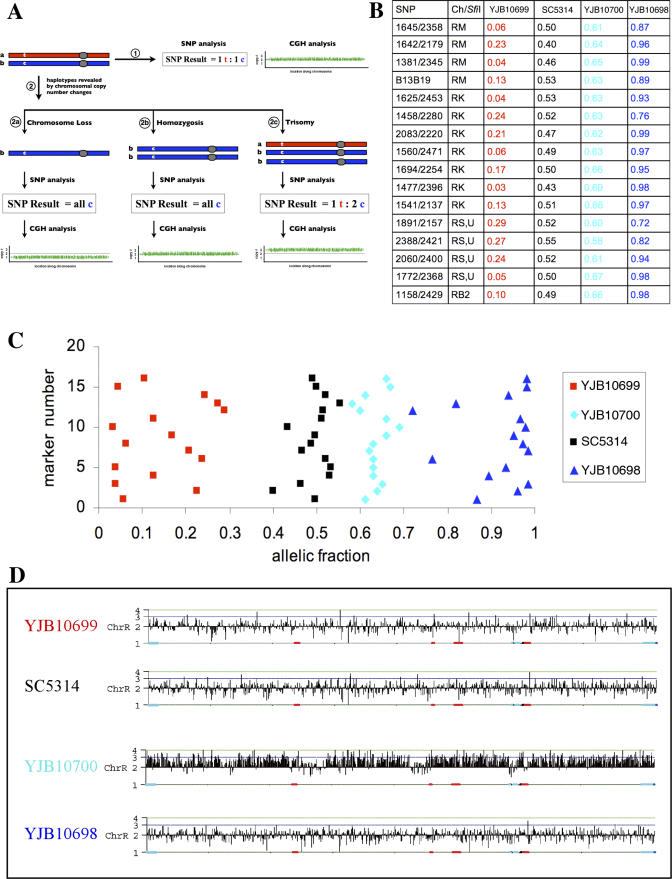
Allelic Fractions from Aneuploid Strains Can Be Used To Generate SNP Haplotype Maps(A) Haplotype determination by chromosomal variation analysis. A typical chromosome pair in C. albicans is depicted in the upper left. One homolog is shown in red, the other in blue, with centromeres indicated as a grey circle. This chromosome pair bears a single nucleotide polymorphism (SNP) on the left arm, shown as a “t” on the red homolog and a “c” on the blue. If this chromosome pair is analyzed (arrow 1), SNP analysis will demonstrate that the two SNP variants are present in a 1:1 ratio, while comparative genome hybridization (CGH) will demonstrate that there are two copies of the entire chromosome. This chromosome pair undergoes an alteration in copy number (arrow 2): simple chromosome loss (2a), loss and homozygosis of the remaining homolog (2b), and duplication of an extra copy of one of the homologs, leading to trisomy (2c). SNP analysis of the chromosome loss event (2a) will show that only one of the two alleles is present, while CGH analysis will indicate a reduction in chromosome number. Analysis of the homozygosis (2b) will give the same SNP result but indicate a diploid chromosome number, while analysis of the trisomy (2c) will show a 1:2 ratio of the SNP alleles and the gain of a third chromosome. These results allow the unambiguous mapping of a particular SNP allele to a particular homolog (designated “a” or “b”).(B) Allelic fractions can be indicative of heterozygous trisomies of whole chromosomes. Allelic fractions (AF) of SNPs on ChR for strains YJB10699, SC5314, YJB10700, and YJB10698, which served as reference strains for the individual genotypes. Allelic fractions were calculated: AF-allele b + AF-allele a/(AF-allele b + AF-allele a). Ranges for genotype calls: AF<0.4−homozygous allele a; AF>0.4 and <0.6 − heterozygous a/b; AF>0.6−homozygous allele b.(C) Plot of allelic fractions for SNP loci on ChR in four reference strains. Allelic fractions for strains YJB10699, SC5314, YJB10700, and YJB10698 (x-axis) and the corresponding SNP (y-axis). Allelic fractions for strains YJB10699, SC5314, and YJB10698 fall into the expected ranges. For strain YJB10700, the allelic fractions fall between the heterozygous and homozygous range indicating a possible trisomy.(D) CGH profiles of ChR for reference strains YJB10699, SC5314, YJB10700, and YJB10698. CGH profiles for ChR for the four reference strains confirm the diploid homozygous state for strains YJB10699 (homozygous a/a) and YJB10698 (homozygous b/b), the heterozygous diploid state for strain SC5314 (a/b), and the trisomic heterozygous state for strain YJB10700 (2× allele a, 1× allele b).